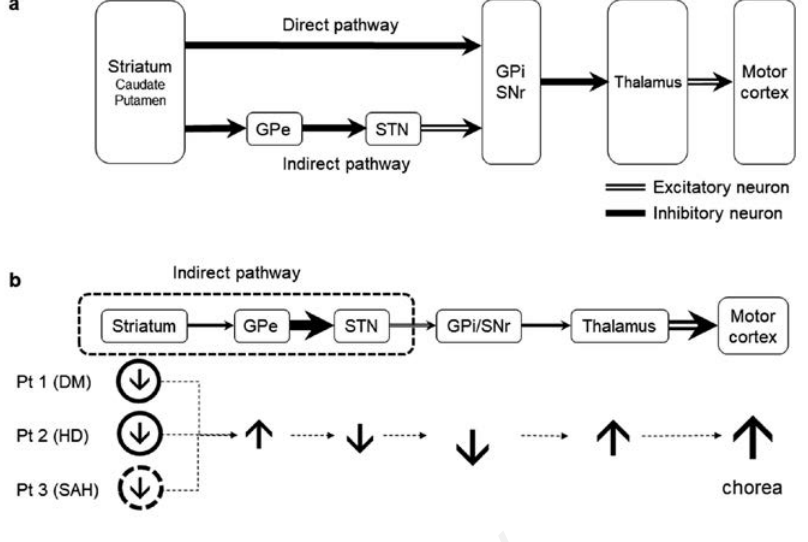
Figure 1. Schematic representation of the basal ganglia circuit and changes in activity of the basal ganglia components in the three patients. (A) The basal ganglia circuit consists of the direct and indirect pathways, which start and stop movements, respectively; (B) The activity of each component of the indirect pathway in the three patients changed as follows; patients 1, 2, and 3 had lesions in striatum, leading to GPi/SNr deactivation; deactivation of the GPi/SNr activated the thalamus, causing chorea. Arrows encircled by solid lines indicate primary lesions. The arrow encircled by dashed lines indicates a puta- tive primary lesion. GPi, globus pallidus internus; GPe, globus pallidus externus; STN,